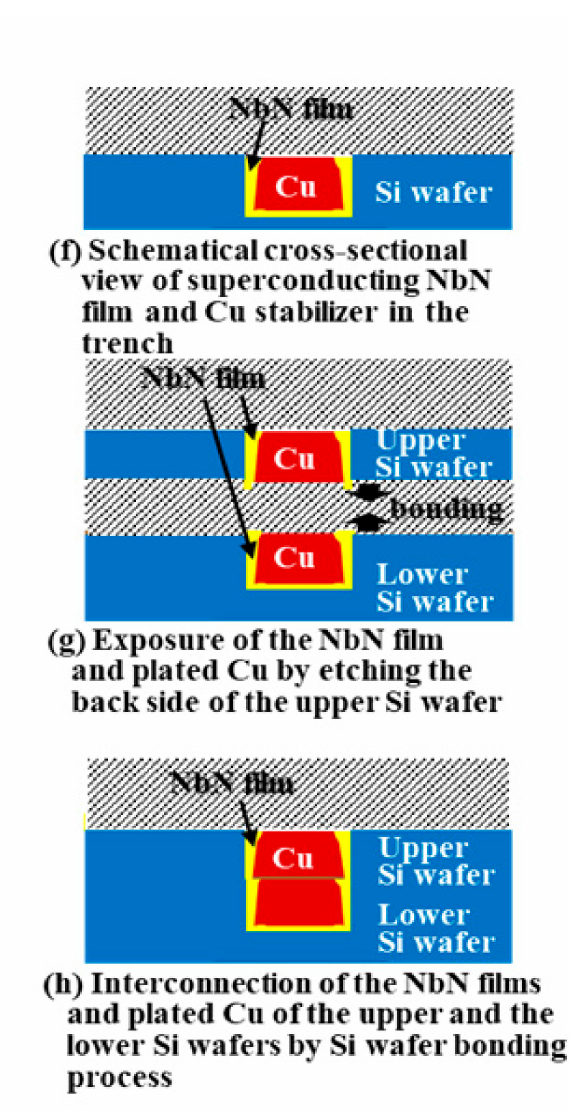
Figure 2. ( a – e ) The processes of trench formation; the deposition of NbN and Cu; and the removal of unnecessary deposits of NbN and Cu, except for those in the trench, by chemical-mechanical polishing (CMP). ( f – h ) Examples of the processes of the wafer bonding and series interconnection of the wafer